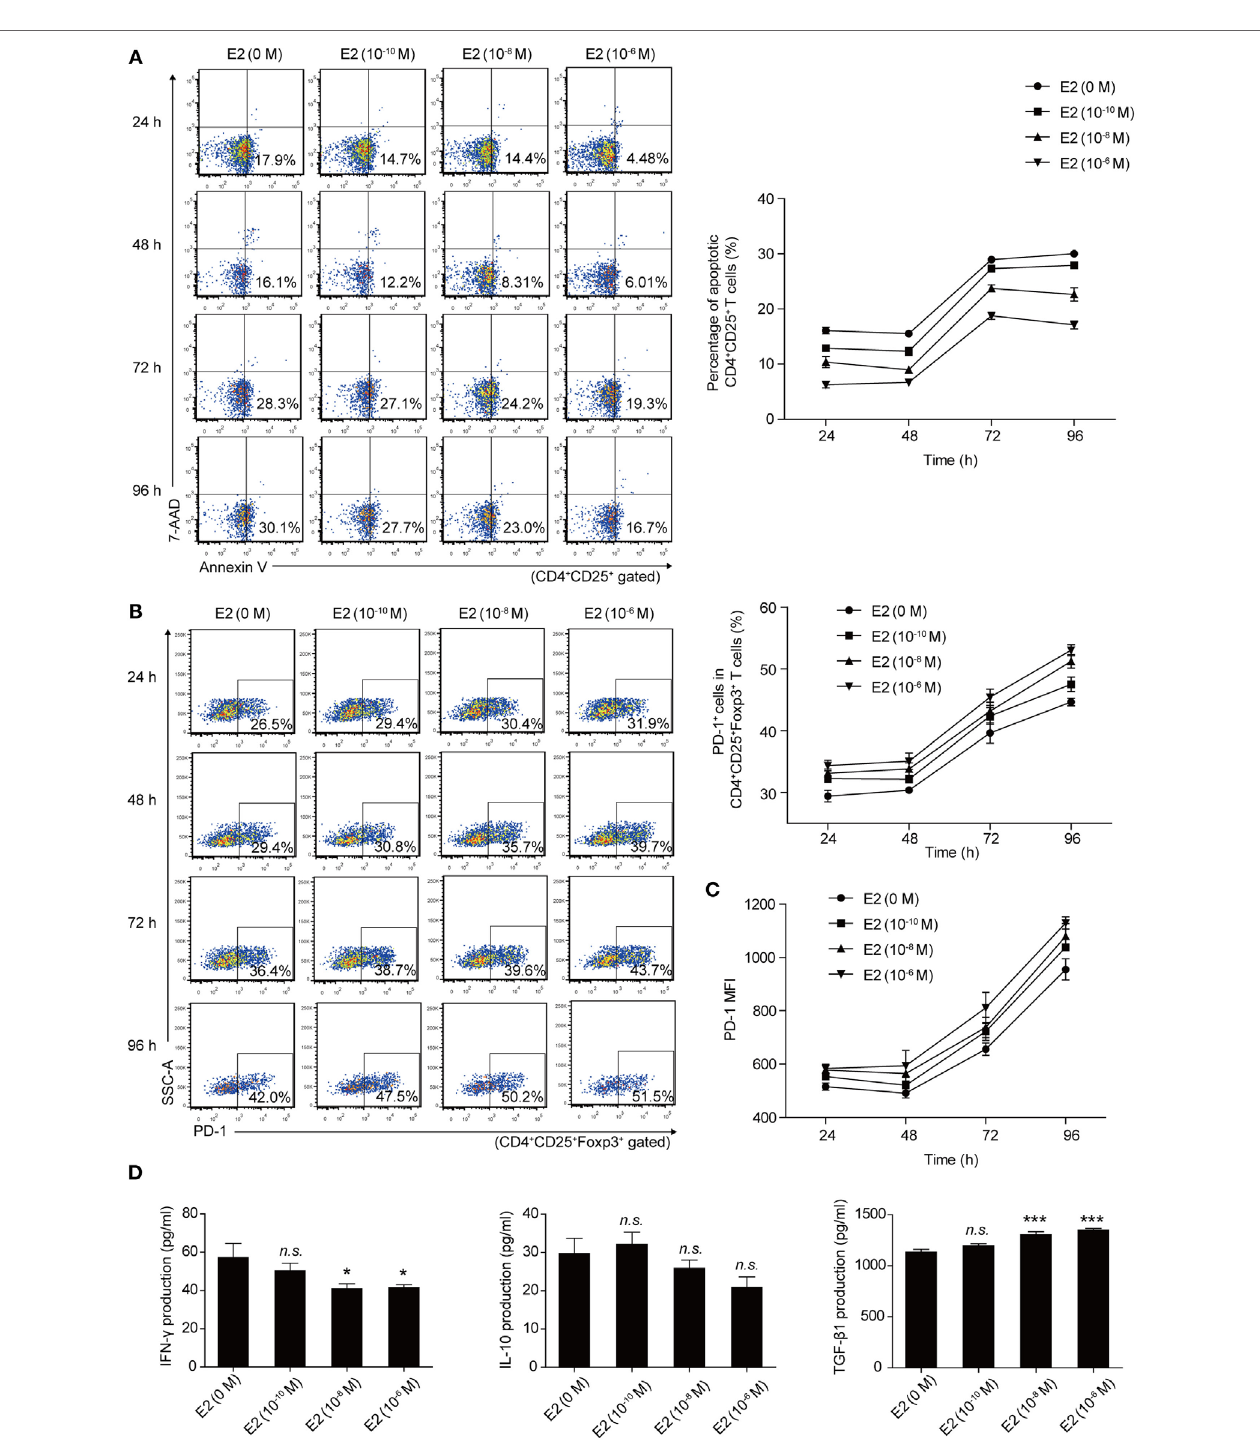
FigUre 5 | Estradiol (E2) inhibited the apoptosis of Tregs and enhanced the programmed death-1 (PD-1) expression on Tregs in a dose-dependent manner. (a) Splenocytes from C57BL/6 mice were treated with E2 ranging from 10 − 10 to 10 − 6 M for 24, 48, 72, and 96 h, respectively. The apoptotic rate of Tregs was estimated by Annexin V/7AAD analysis gated on CD4 + CD25 + T cells. Data are presented as the means ± SD ( n = 6). (B) Splenocytes were treated with E2 as mentioned above. The percentage of PD-1 + cells in CD4 + CD25 + Foxp3 + T cells was evaluated by flow cytometry. Data are expressed as the means ± SD ( n = 6). (c) Mean fluorescence intensity (MFI) of PD-1 expression on CD4 + CD25 + Foxp3 + T cells. Data are presented as the means ± SD ( n = 6). (D) The levels of IFN- γ , IL-10, and TGF- β 1 secretion by mouse splenocytes stimulated with E2 ranging from 10 − 10 to 10 − 6 M for 96 h. Data are represented as the means ± SD ( n = 6). Significance was analyzed using one-way ANOVA. *** P < 0.001, * P < 0.05, n.s. P >